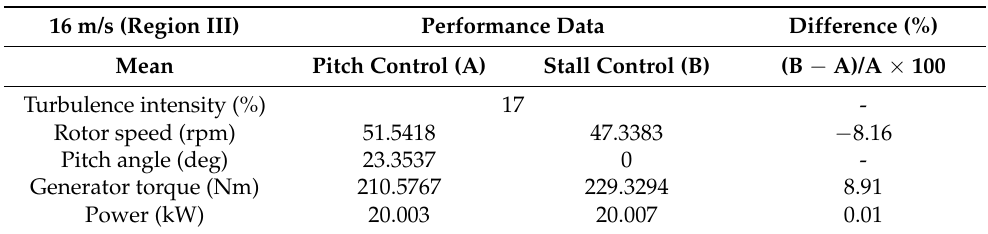
Table 3. Quantitative comparison of controller performance at an average wind speed of 16 m/s (mostly Region III).